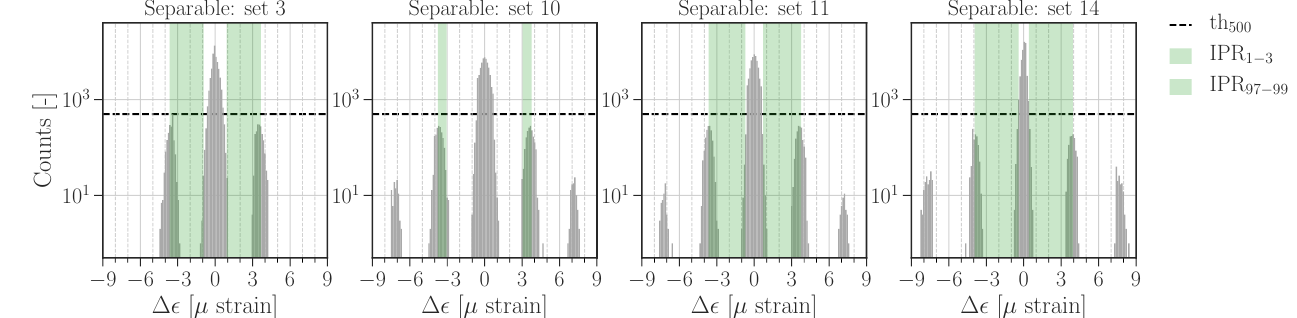
Figure A2. Histogram of sample wise strain difference signals for four separable cases, including inter percentile ranges (IPR).